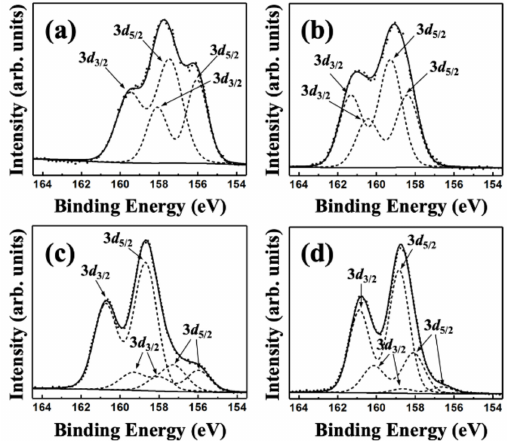
Figure 4. Peak positions of the XPS spectra of the surface; ( a ) Y 2 O 3 and ( b ) YO 0.6 F 2.1 before etching, ( c ) Y 2 O 3 and ( d ) YO 0.6 F 2.1 after